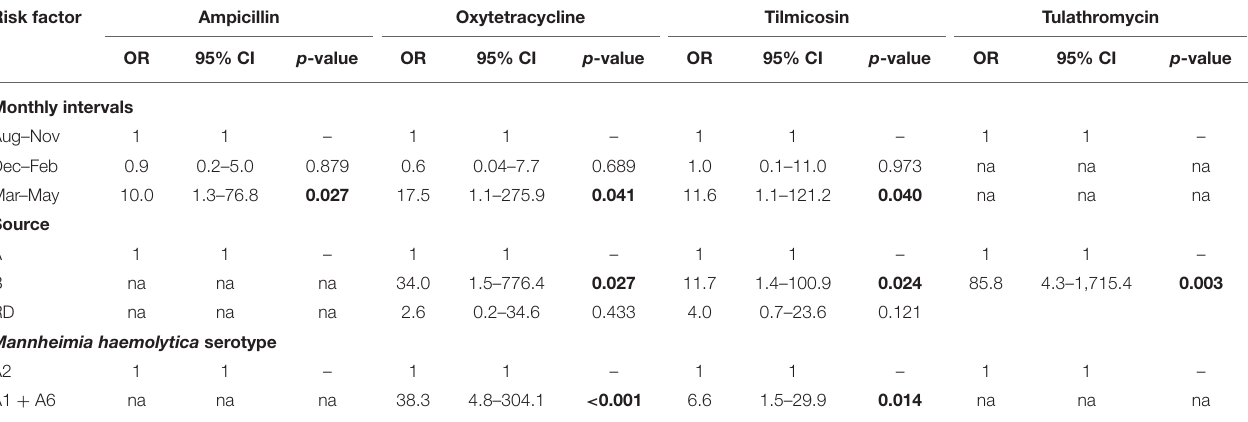
TABLE 5 | Significant results obtained from logistic regression of antimicrobial resistant Mannheimia haemolytica from beef-type cattle upon feedlot arrival. Risk factor Ampicillin Oxytetracycline Tilmicosin